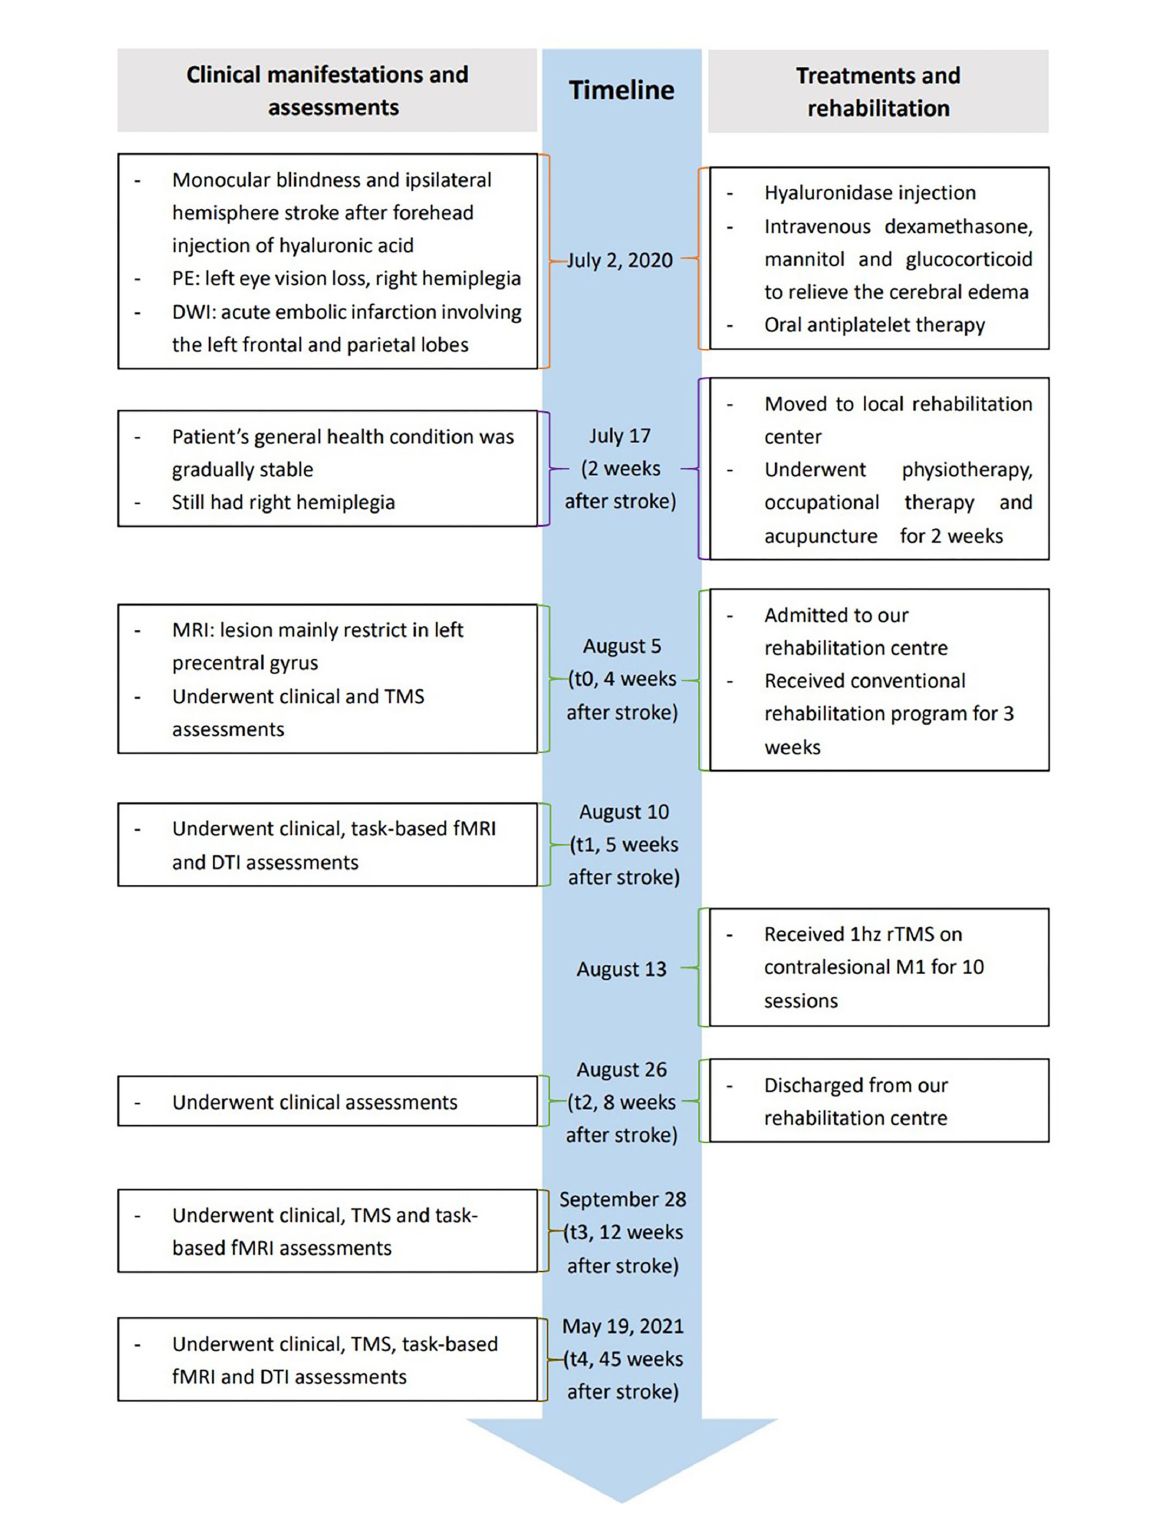
FIGURE1 Timeline of relevant data, interventions, and